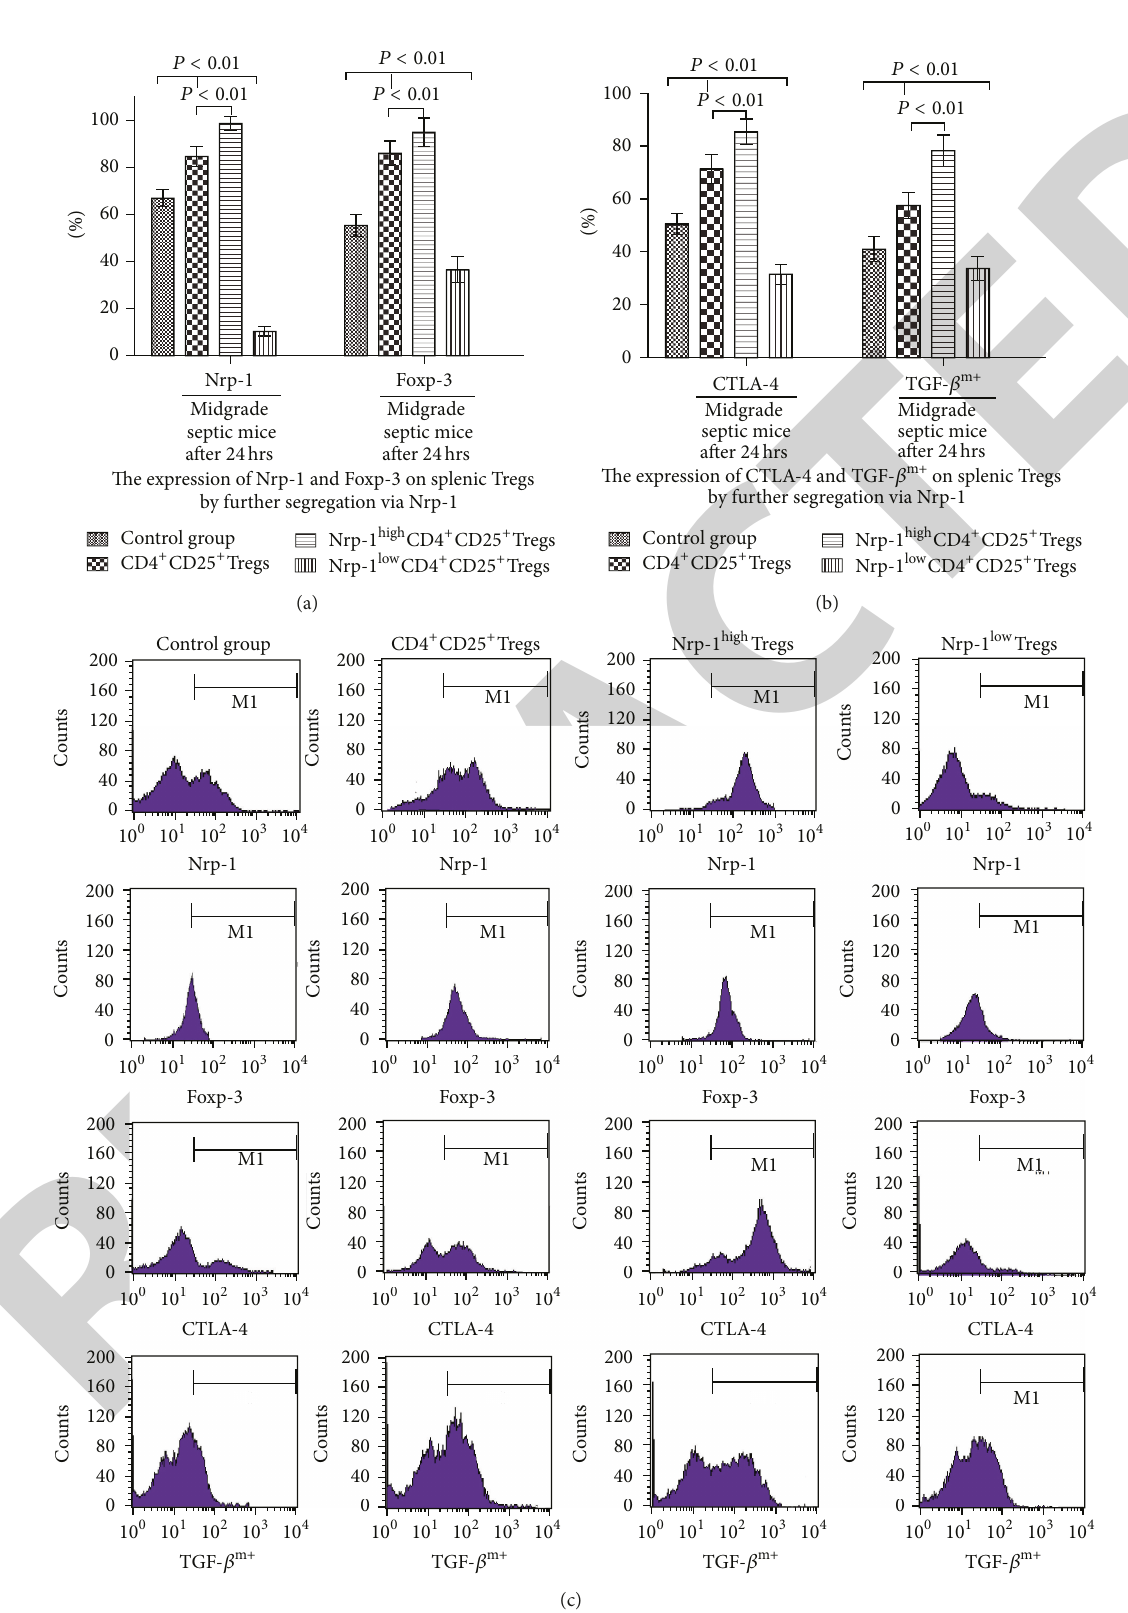
Figure 2: Sepsis markedly upregulated the expression of Foxp-3/CTLA-4/TGF- 𝛽 m + on Nrp- 1 high CD 4 + CD 25 + Tregs. Midgrade septic model at 24 hours after CLP was used to investigate the effect of Nrp-1 on the negative immunoregulation of Tregs in sepsis. The expressions of Nrp-1 and Foxp-3 ((a), (c)) and CTLA-4 and TGF- 𝛽 m + ((b), (c)) were subjected to flow cytometric analysis by flow cytometer. Data was represented as mean ± standard deviation (SD) and analyzed by SPSS 17.0 software with a one-way ANOVA, 𝑛 = 4 per group ( 𝑃 < 0.01